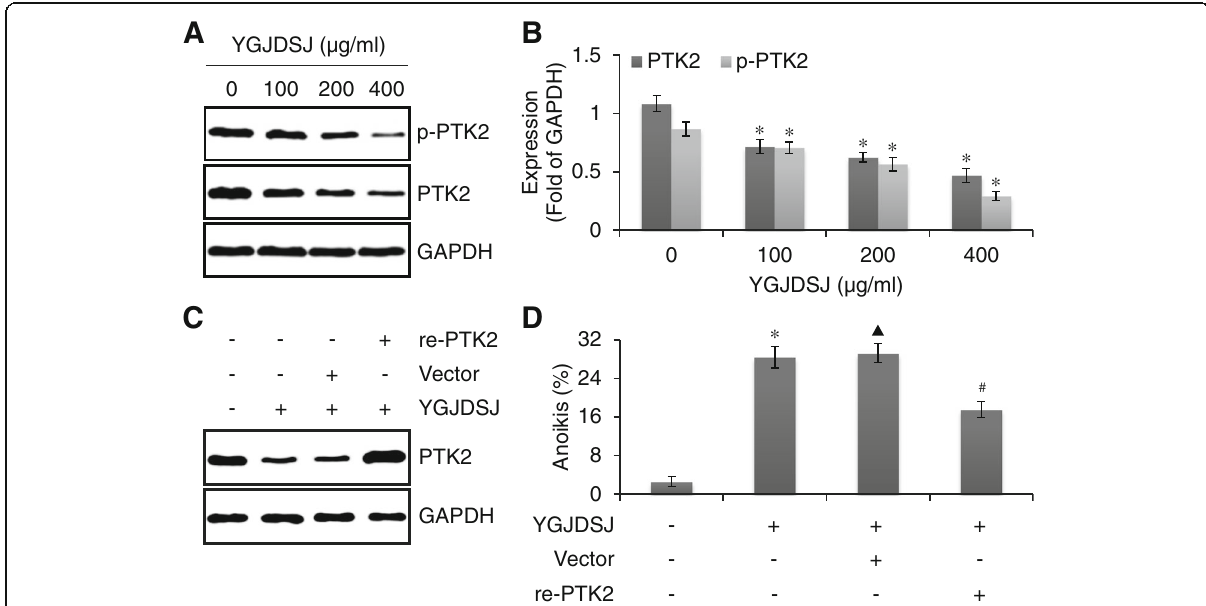
Fig. 5 YGJDSJ inhibited PTK2 expression and phosphorylation in Bel-7402 cells. Suspension-cultured Bel-7402 cells were collected after YGJDSJ treatment, subjected to western blots using indicated antibodies ( a ), and the expression of proteins were expressed as fold of GAPDH ( b ). Bel-7402 cells were transfected with recombinant human PTK2 and empty vector, and subjected to suspension-culture, YGJDSJ (200 μ g/ml) treatment for 24 h, western blots using indicated antibodies ( c ) and anoikis detection ( d ). * P <0.01, versus control group; ▲ P >0.05, versus control YGJDSJ group; # P <0.01, versus YGJDSJ treated vector